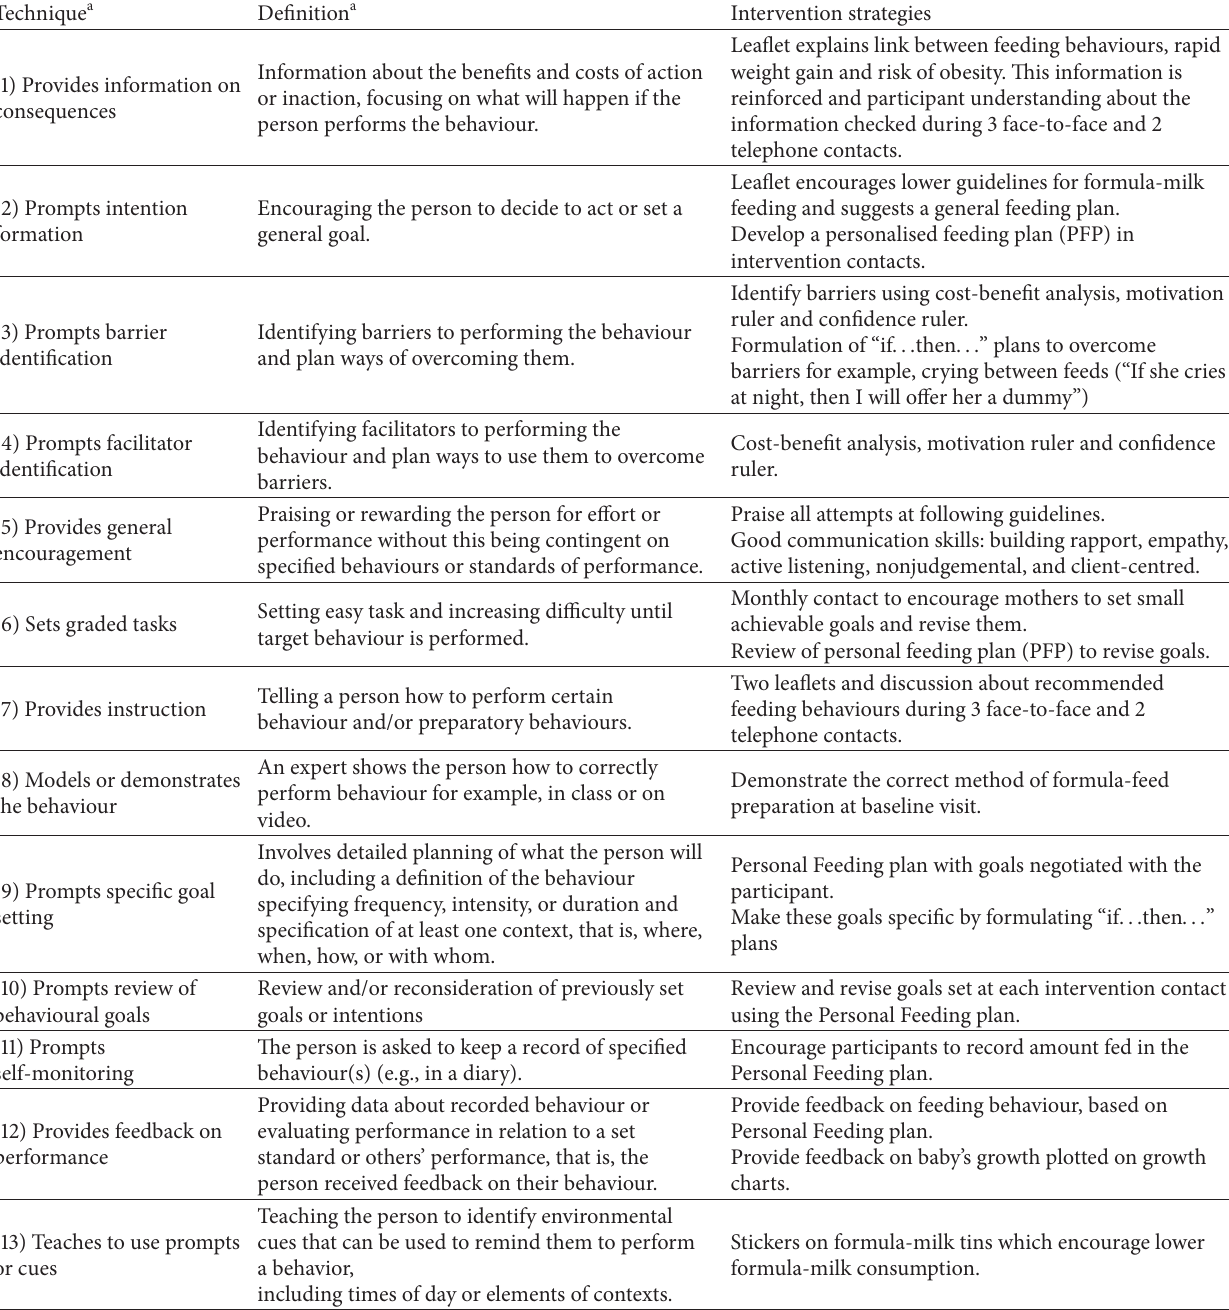
Table 2: Behaviour change techniques and intervention strategies used in the baby milk intervention